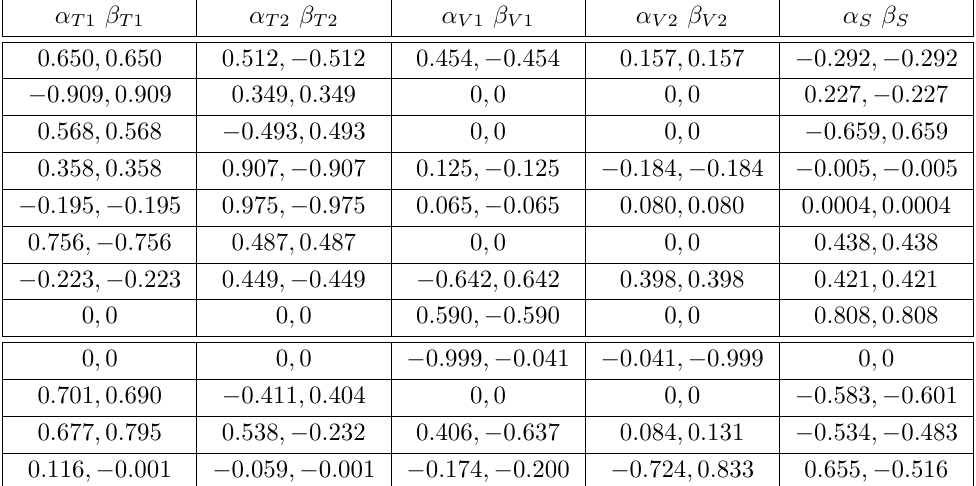
Table 3 . Special con(cid:12)gurations of polarizations for hf ! hf scatterings in SVT basis which give strong constraints on the couplings. These are determined by minimizing the (cid:11) ’s and (cid:12) ’s for guessed Lagrangian parameters. This procedure is repeated until a compact parameter region is obtained. In the case of line theories, the last four con(cid:12)gurations of polarizations are needed, in addition to the (cid:12)rst seven, to give strong constraints on the